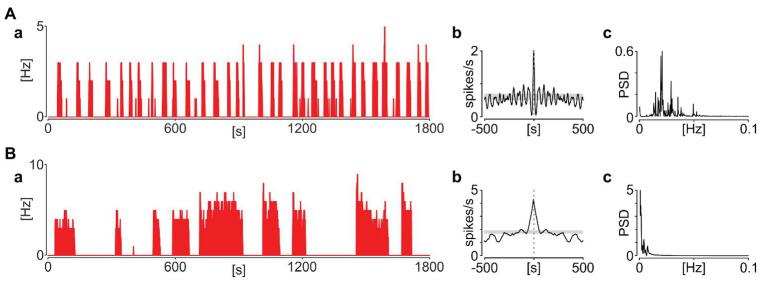
Phasic activity pattern in the NTS is rarely periodic. (A) Example of a rare periodic unit. (B) Representative non-periodic activity. (a) Firing rate histograms (bin: 1 s). (b) Autocorrelograms (bin: 1 s). Grey boxes code 95% CIs. (c) Periodograms. PSD – power spectral density.